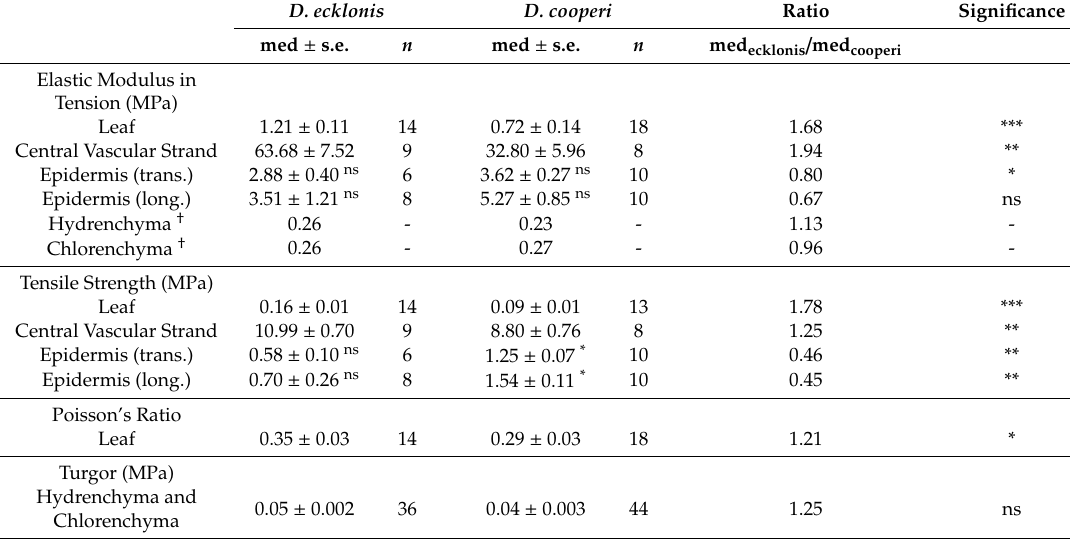
Table 2. Mechanical properties and additional mechanically important characterization of entire leaves and single tissue layers of D. ecklonis and D. cooperi . The median value (med), the standard error (s.e.) and the sample size ( n ) for each parameter are given. The results of the inter- and intraspecific statistical analyses are both based on Wilcoxon-Mann-Whitney signed rank tests. The statistical significance of intraspecific comparisons is given as super-scripts behind the respective sample medians. Values for D. ecklonis are taken from [33,34]. Values for D. cooperi are taken from [16]. D. ecklonis D. cooperi Ratio Significance med ± s.e. Elastic Modulus in Tension